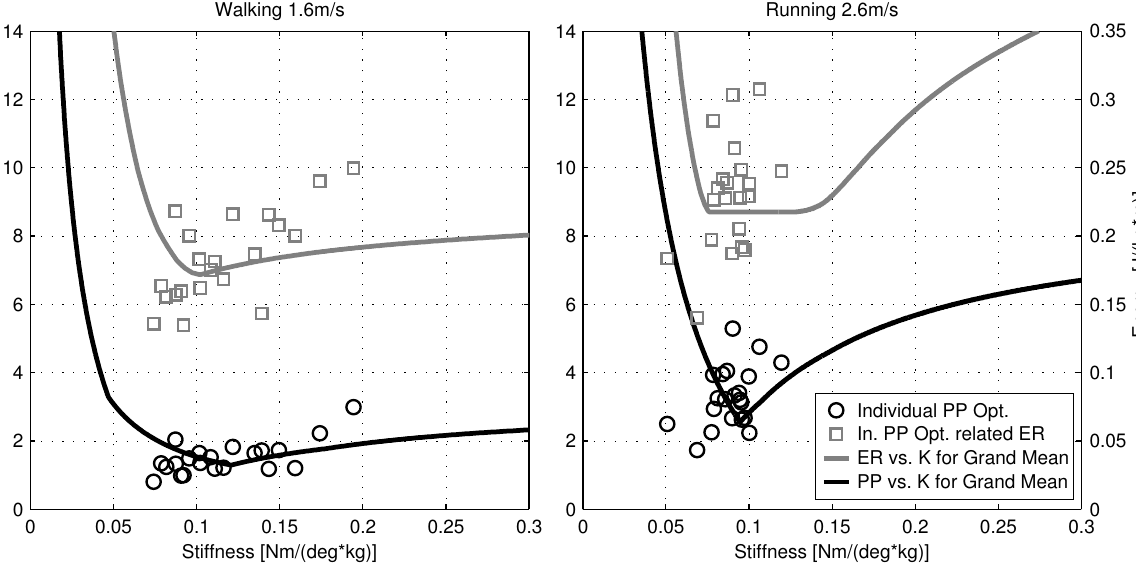
ERIndividual PP MeanIn. PP Opt. related MeanER vs. K for Grand PP vs. K for Grand